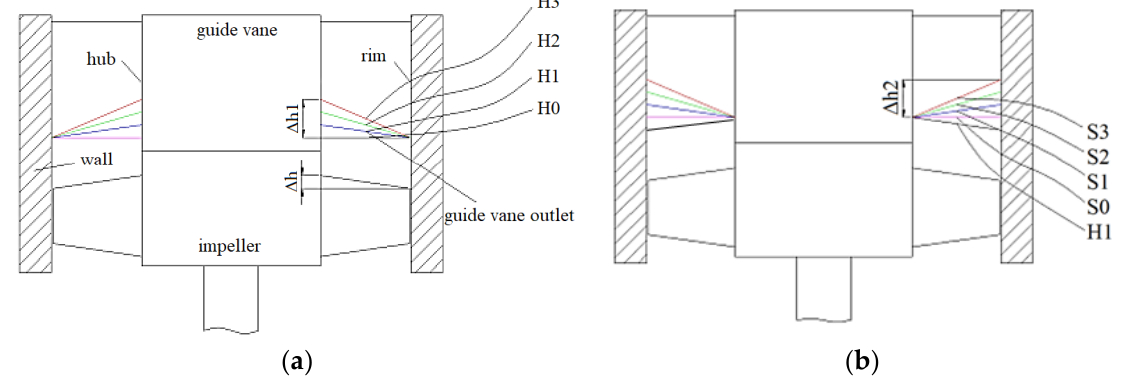
Figure 2. The settings of the two schemes: ( a ) Plan H; ( b ) Plan